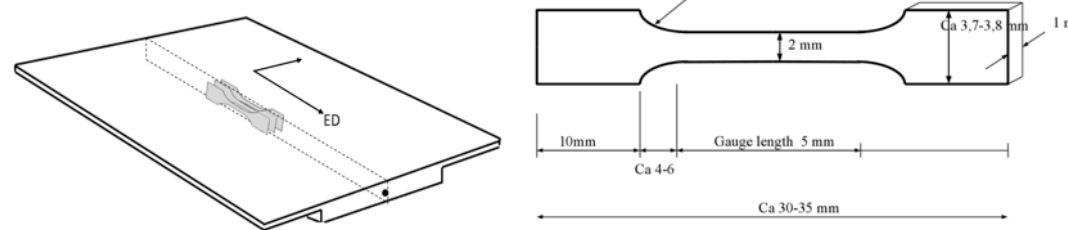
Figure 4. Position in the sample from which tensile specimens were obtained ( left ) and tensile specimen dimensions ( right ).